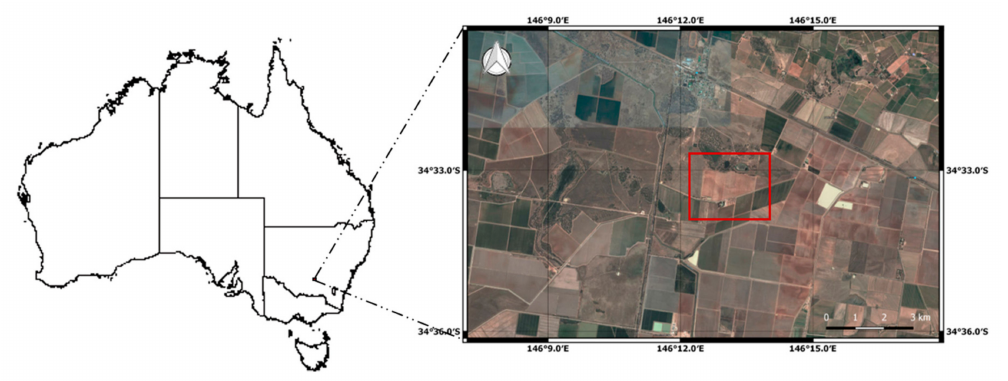
Figure 1. Location of the commercial cotton farm where the study was conducted in Whitton, NSW, Australia.